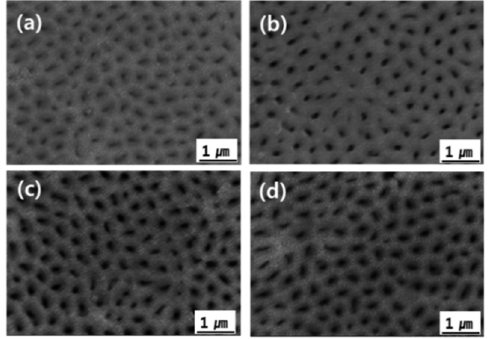
Figure 6. FE-SEM images of AAO films after exposure to CF 4 /Ar/O 2 plasma: ( a ) No, ( b ) 1 mM, ( c ) 2 mM, and ( d ) 3 mM Ce ion.